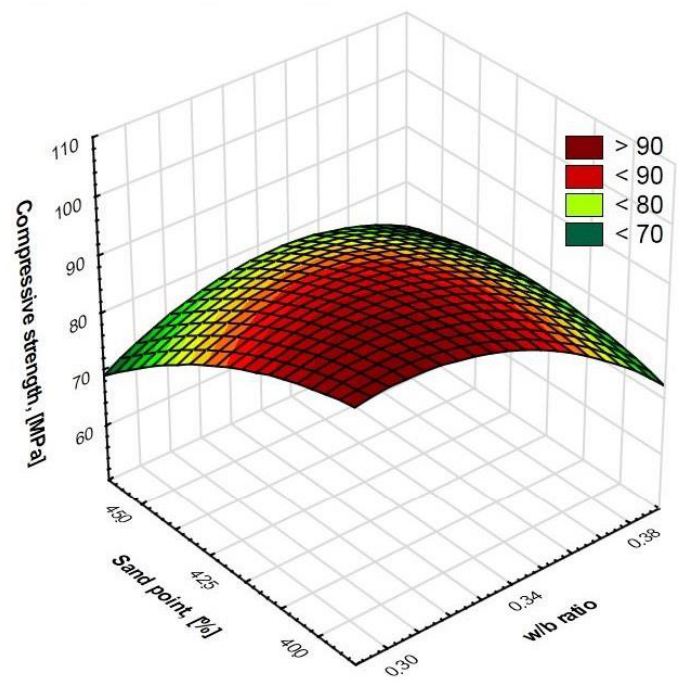
Figure 8. Surface chart. Relationship between w/b ratio and sand point on compressive strength. R 2 = 0.97.